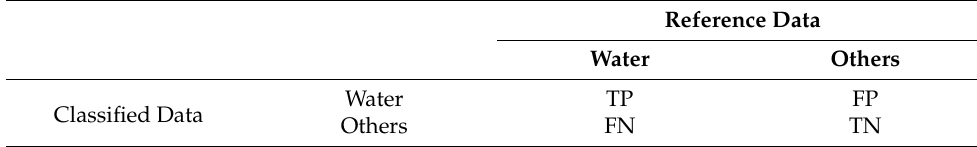
Table 2. Confusion